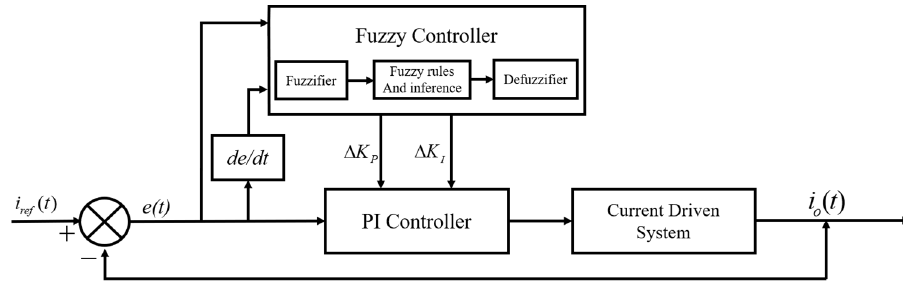
Figure 5. Fuzzy PI controller block